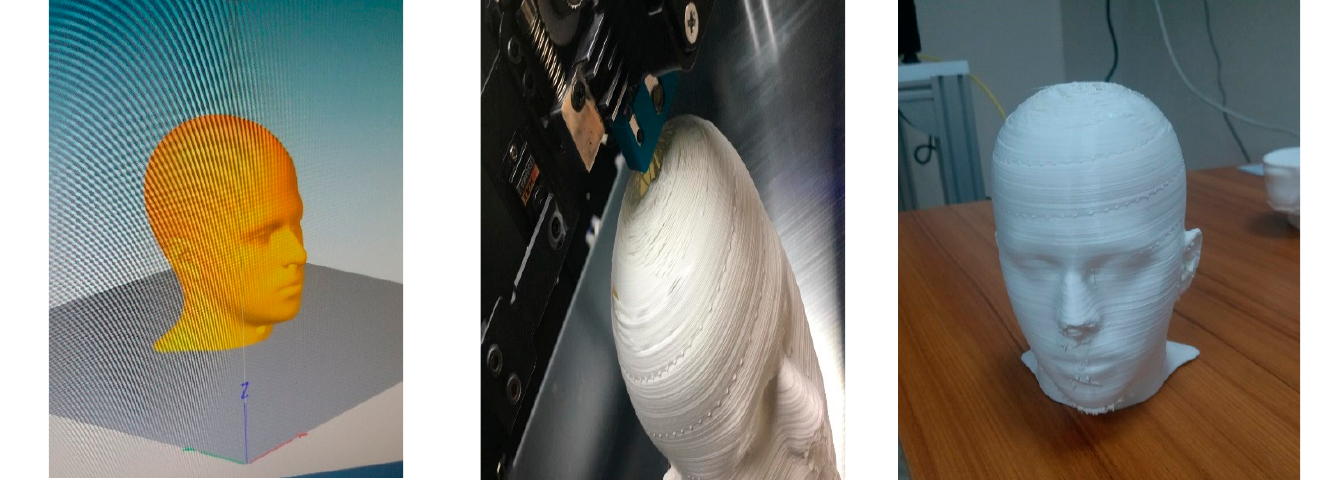
Figure 1. Production steps of the head model.